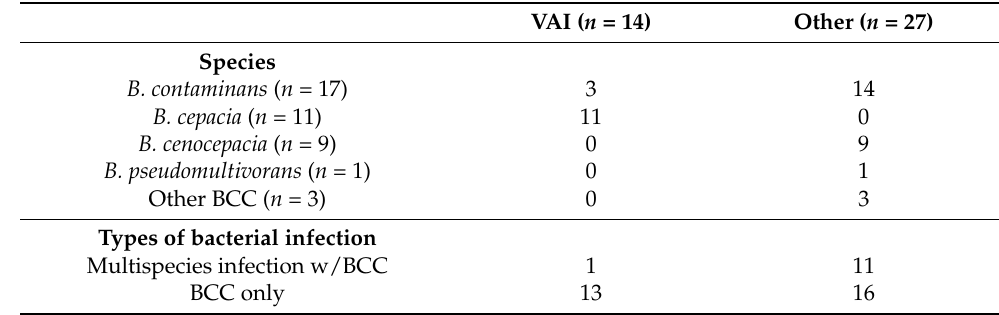
Table 2. The distribution of Burkholderia species in different clinical infections.